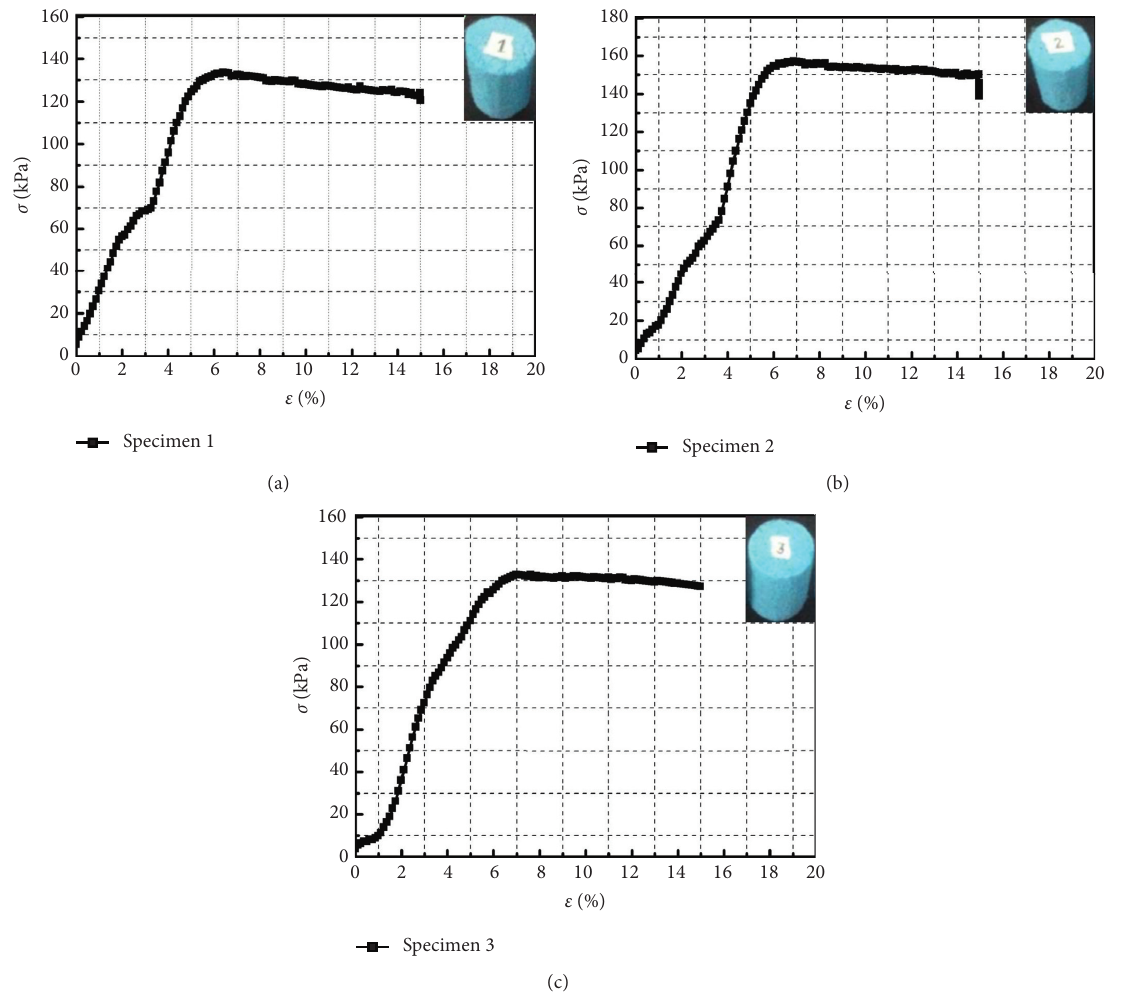
Figure 6: Stress-strain